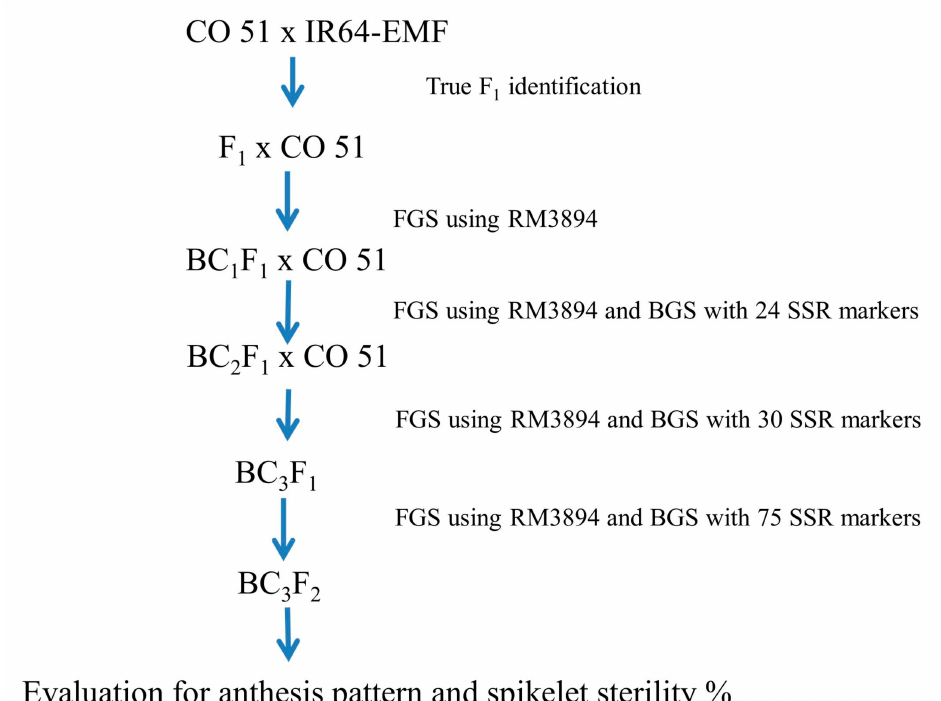
Figure 1. Marker-assisted backcross breeding strategy for the development of early morning flower- ing version of rice cultivar CO